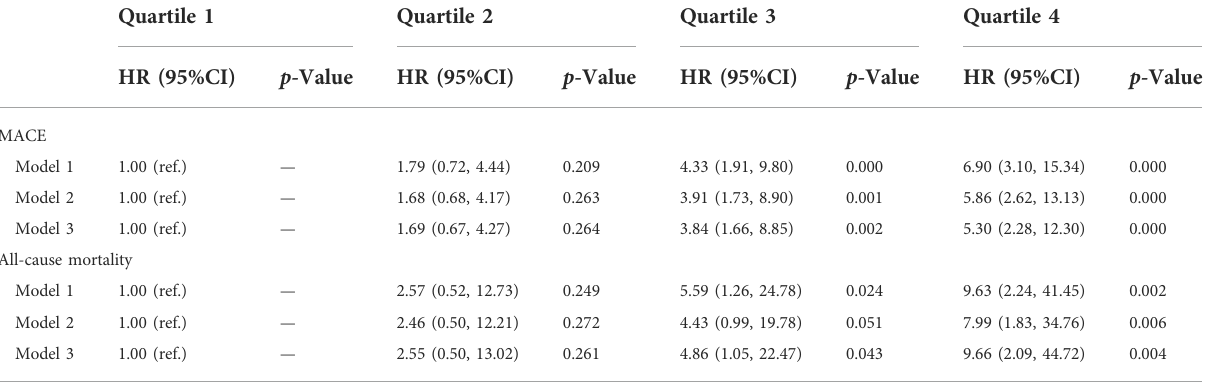
TABLE 4 HRs and 95% CIs of clinical outcomes according to quartiles of serum Cys-C.